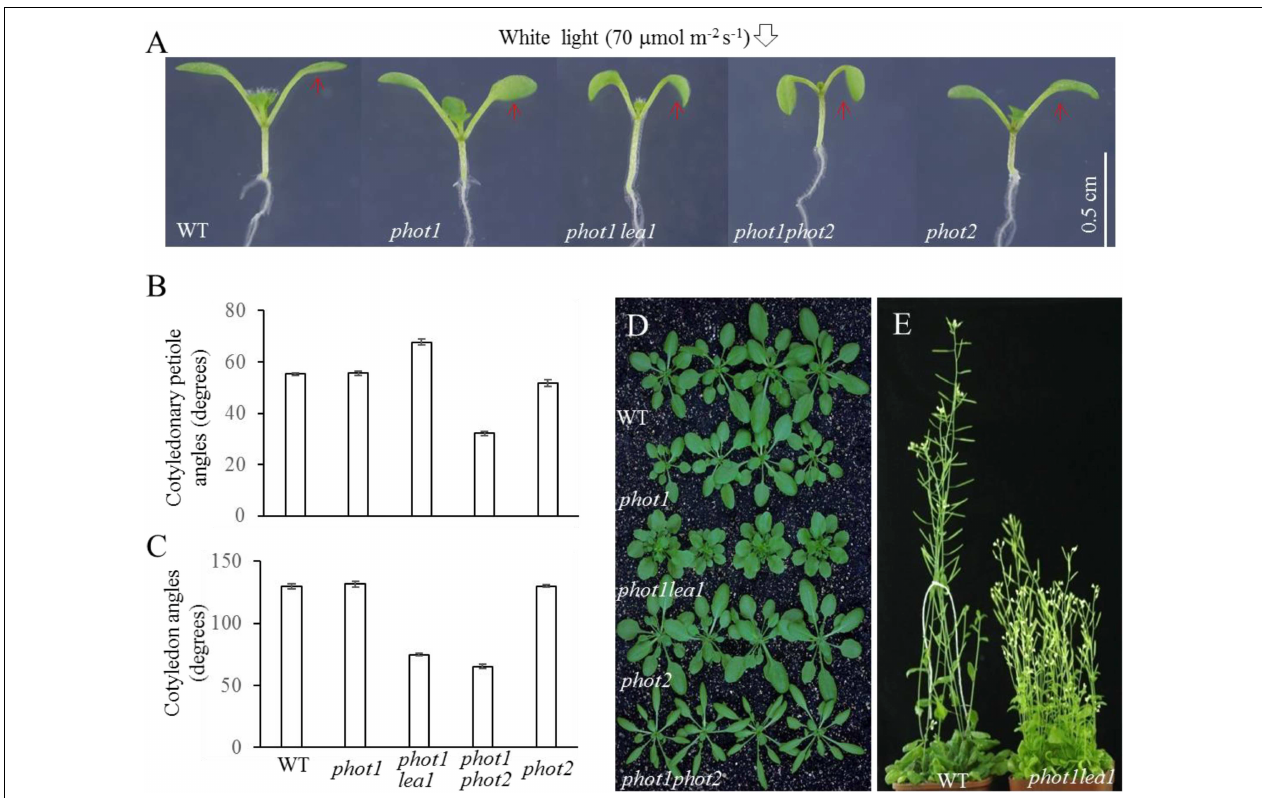
FIGURE 1 | Phenotype analysis of phot1 lea1 and related mutants. (A) Cotyledon flattening and positioning of wild-type (WT), phot1 , phot1 lea1 , phot1 phot2 , and phot2 plants grown for 7 days under white light. (B) Cotyledonary petiole angle of seedlings represented in panel (A) . (C) Cotyledon angle of seedlings represented in panel (A) . Each bar represents an average of three experiments (15–20 measurements per experiment) ± SE. (D) True leaves of WT, phot1 , phot1 lea1 , phot1 phot2 , and phot2 plants grown under white light for 1 month. (E) Phenotype of WT and lea1 at